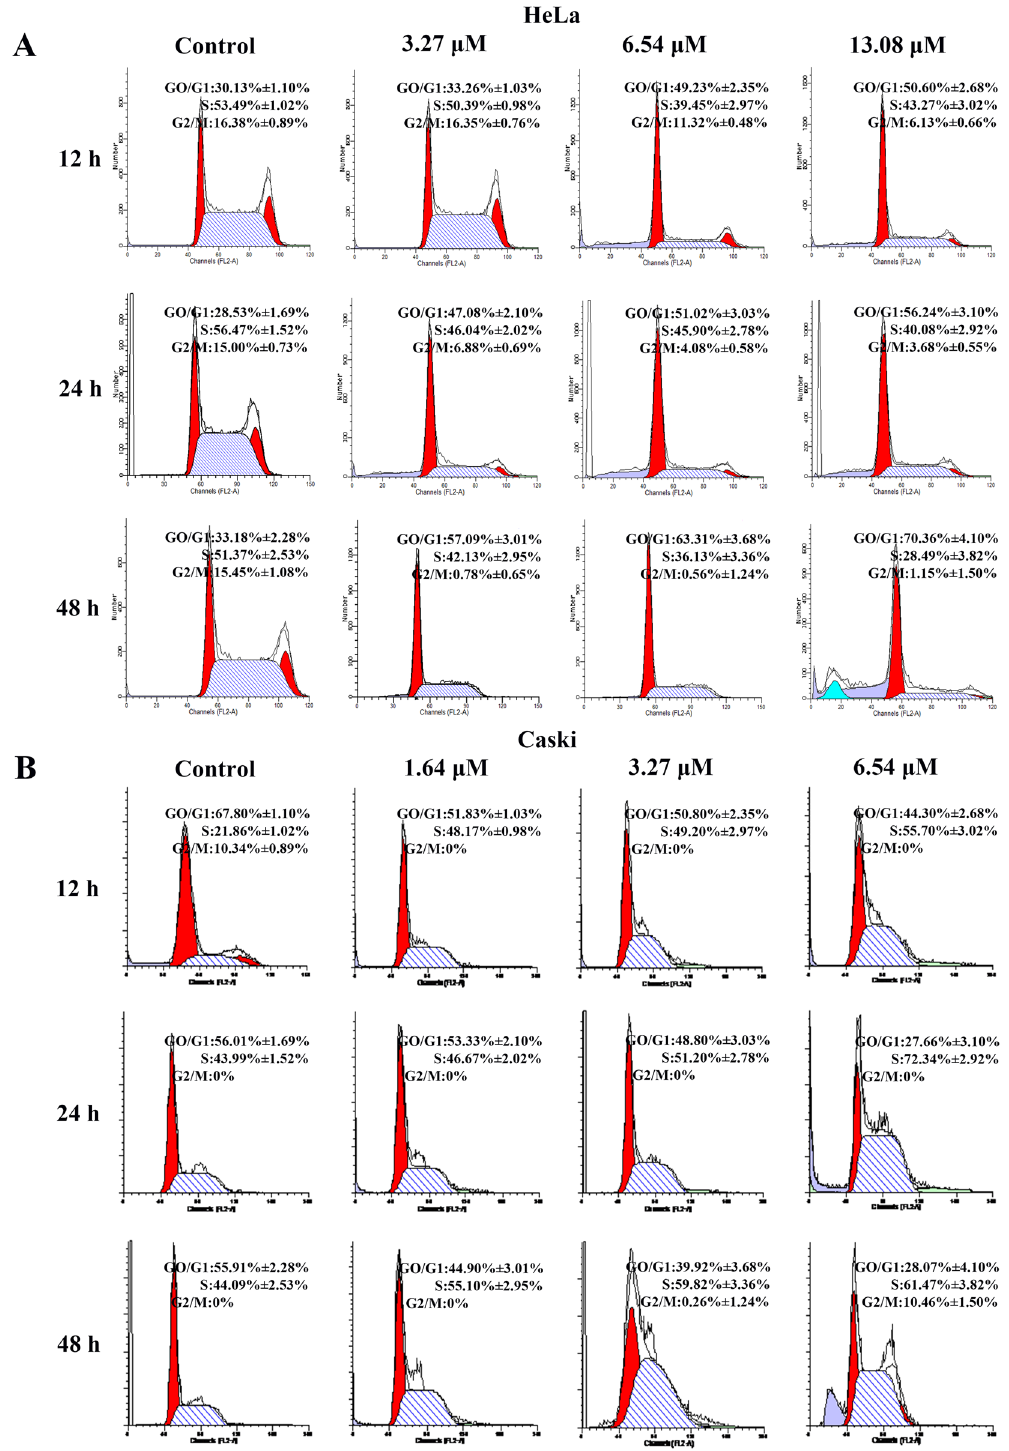
Figure 2. Zey induces cell cycle arrest in HeLa and CaSki cells. Cell cycle distributions of HeLa cells ( A ) and CaSki cells ( B ). HeLa and CaSki cells were treated with Zey for 12, 24, and 48 h, stained with propidium iodide, and then measured by flow